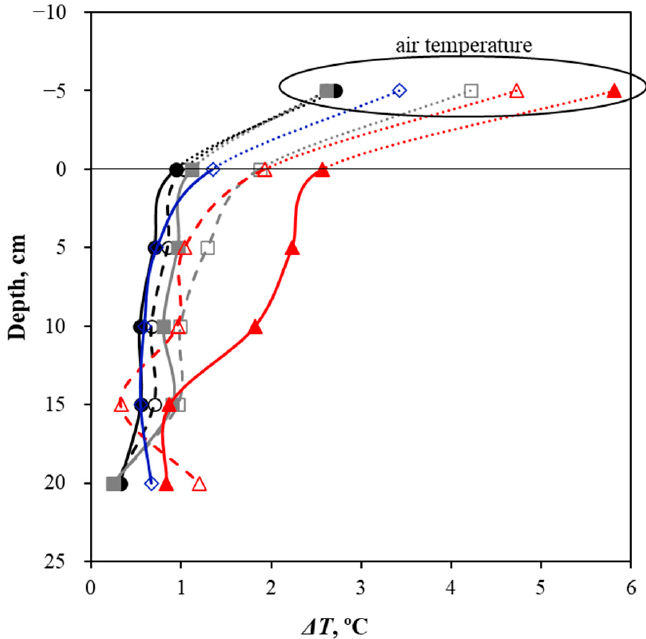
Figure 9. Difference in soil temperature with low tunnel and without low tunnel at different times on the third day of the test (5 March 2015) and at different depths: at 0:00 ( ● ), 2:00 ( ○ ), 6:00 ( ■ ): 10:00 ( □ ), 14:00 ( ▲ ), 18:00 ( Δ ), and 22:00 ( ◊ ) hours.